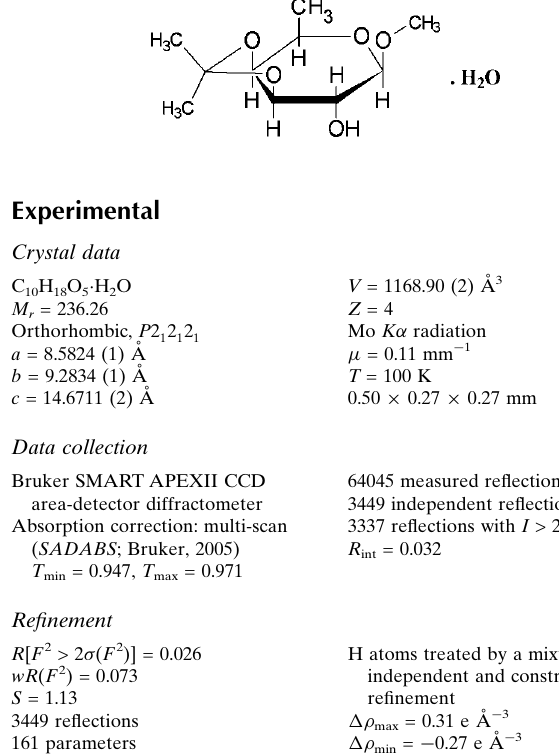
64045 measured reflections 3449 independent reflections 3337 reflections with I > 2 (cid:1) ( I ) R int = 0.032